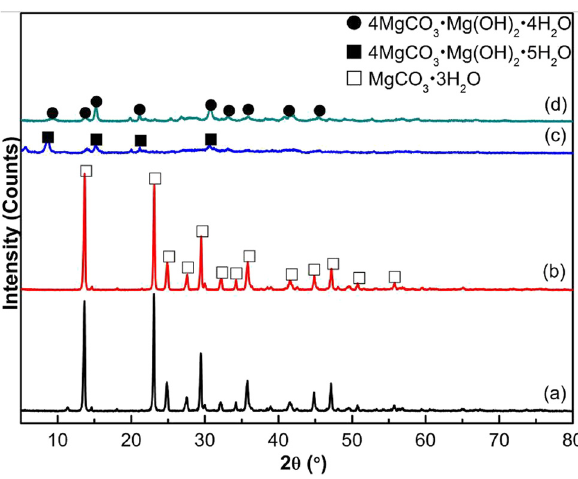
Figure 7: XRD patterns for the carbonation products with di ff erent aging temperatures: ( a ) 60°C, ( b ) 70°C, ( c ) 80°C, and ( d )